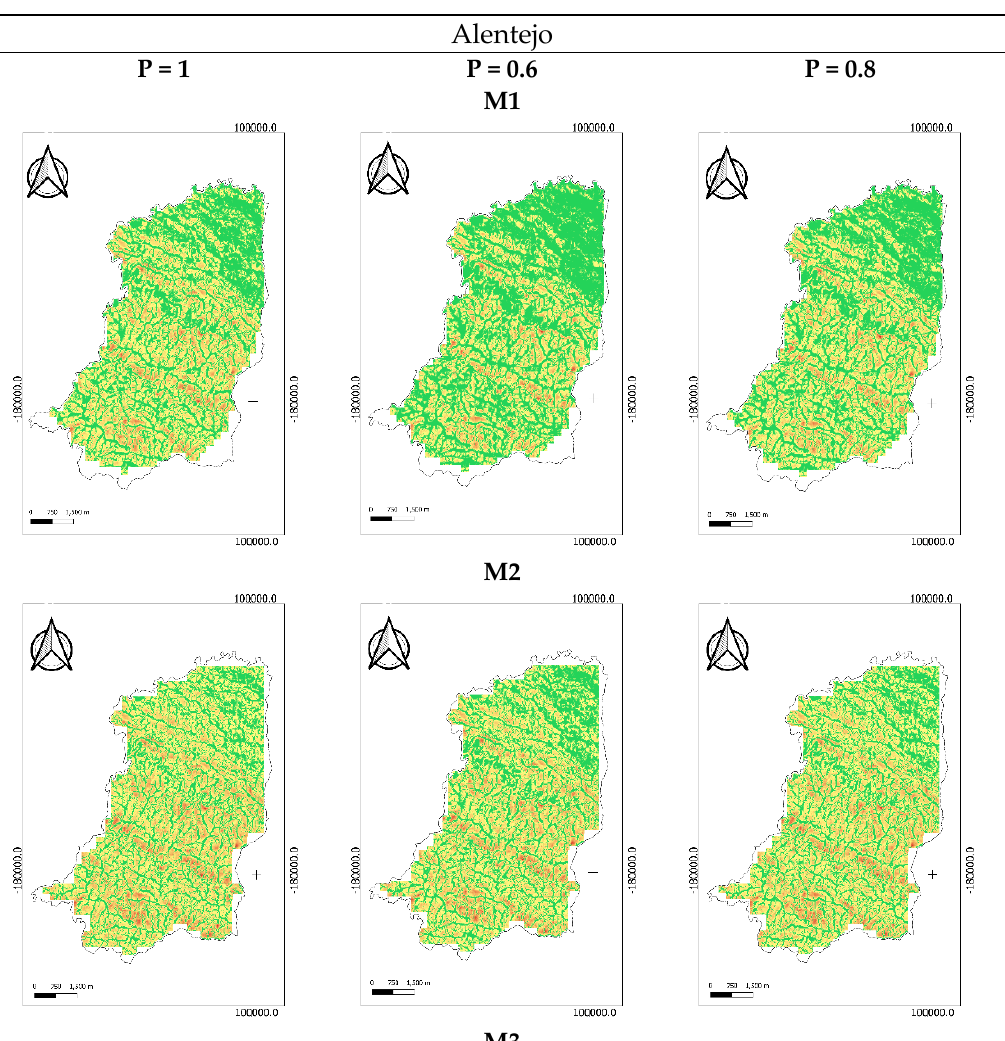
Figure 3. Montalegre erosion soil map results from the eight methodologies and using different combinations ( M1 Rw × Kw × LSw; M2 R jrc × K jrc × LS w ; M3 R w × K w × LS m ; M4 R jrc × K jrc × LS m ; M5 R w × K w × LS mw ; M6 R jrc × K jrc × LS mw ; M7 R w × K w × LS mc ; M8 R jrc × K jrc × LS mc .).